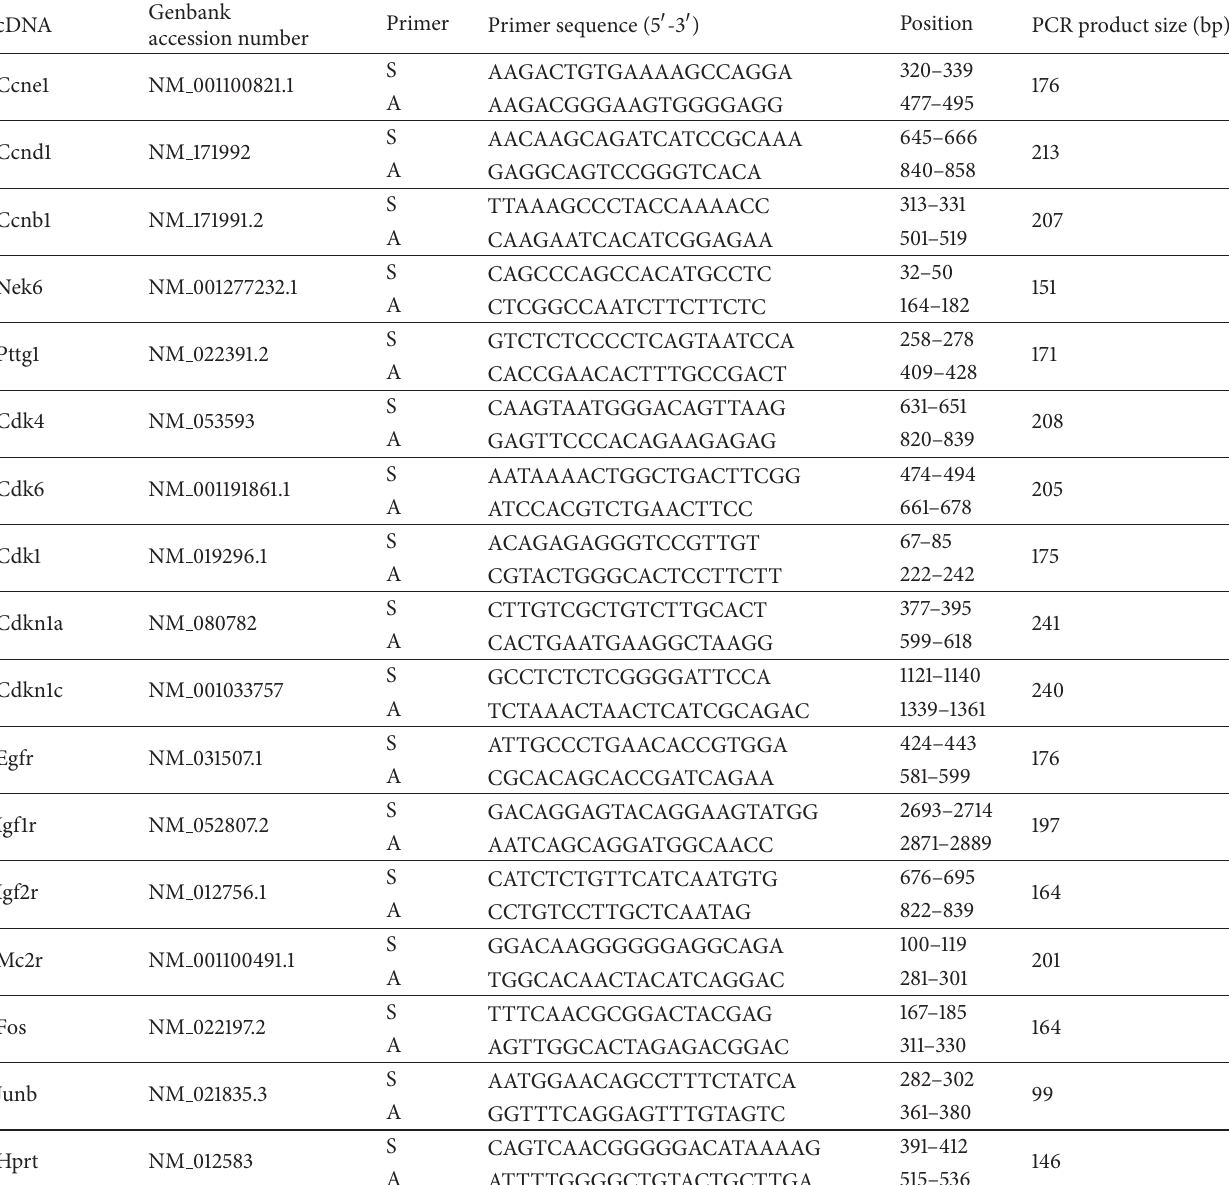
Table 2: Conventional RT-PCR and QPCR analyses of Ccne1—cyclin E, Ccnd1—cyclin D1, Ccnb1—cyclin B, Nek6—NIMA- (never in mitosis gene a-) related kinase 6, Pttg1—pituitary tumor-transforming 1, Cdk4—cyklin-dependent kinase 4, Cdk6—cyklin-dependent kinase